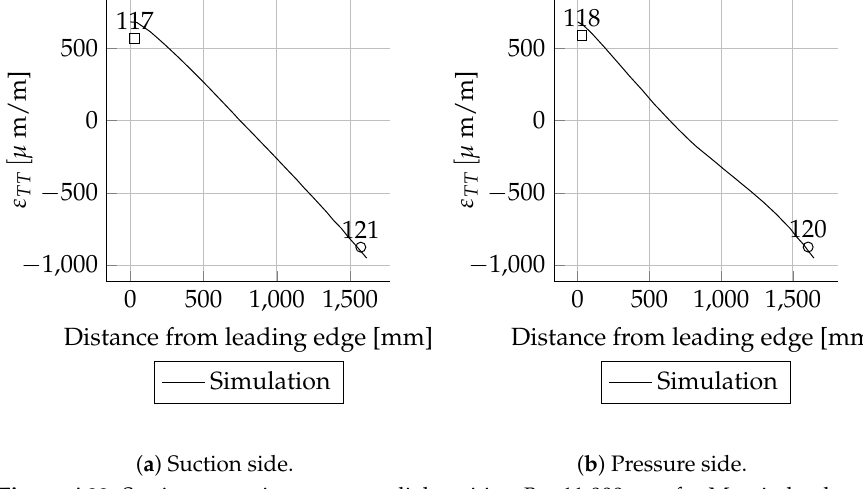
Figure A22. Strain comparison ε LL at radial position R = 11,000 mm for Mxmin load case.